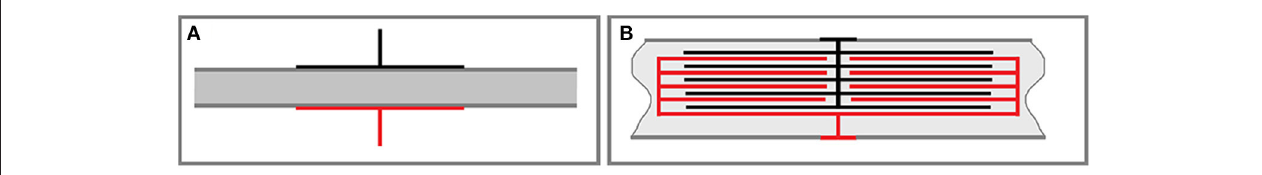
FIGURE 1 | (A) Principle concept of a capacitive feedthrough: metal layers are added to the in- (red) and outside (black) of a non-conductive casing material (gray). The metal layers form a capacitive structure, which can be used to transmit charge pulses through the casing’s wall, (B) advanced structure for a capacitive feedthrough: by integrating parts or all of the capacitive structure into the non-conductive material, dielectric widths can be decreased, and several capacitive layers can be added to greatly increase the resulting capacity.